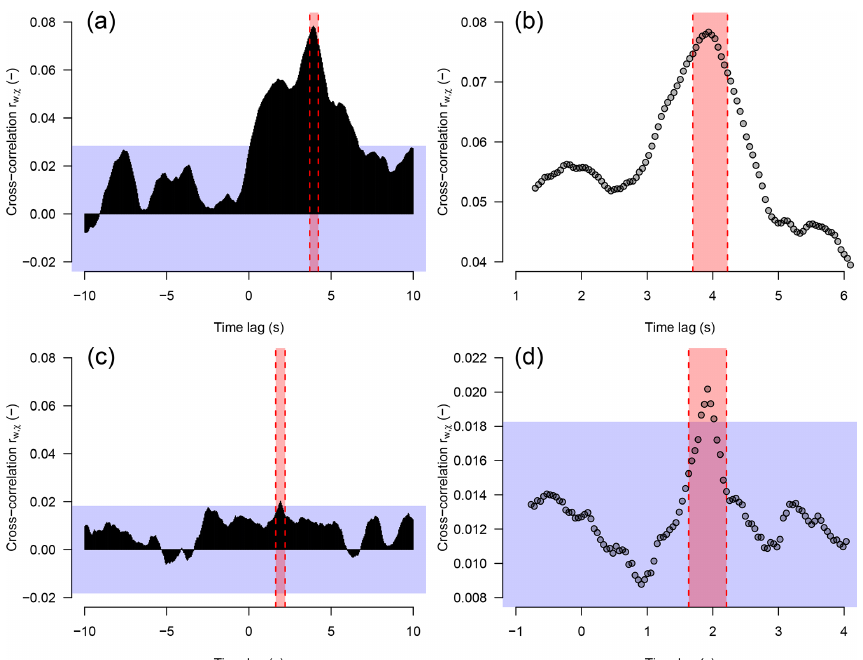
Figure 5. Cross-correlation analysis to determine the time lag between the vertical wind speed ( w ) and Hg 0 time series ( χ ). (a, b) An example with a clearly positive Hg 0 flux (21 July 2018, 10:00–11:00), and (c, d) an example with a marginally positive flux (6 September 2018, 01:00– 02:00). Panels (a) and (c) show the cross-correlation within a time lag window of ± 10s, and panels (b) and (d) zoom in to the search window used in this study (vertical red band). The blue horizontal band shows the range of zero fluxes (cross-correlation r w,χ (cid:54)= 0 with p ≥ 0 .